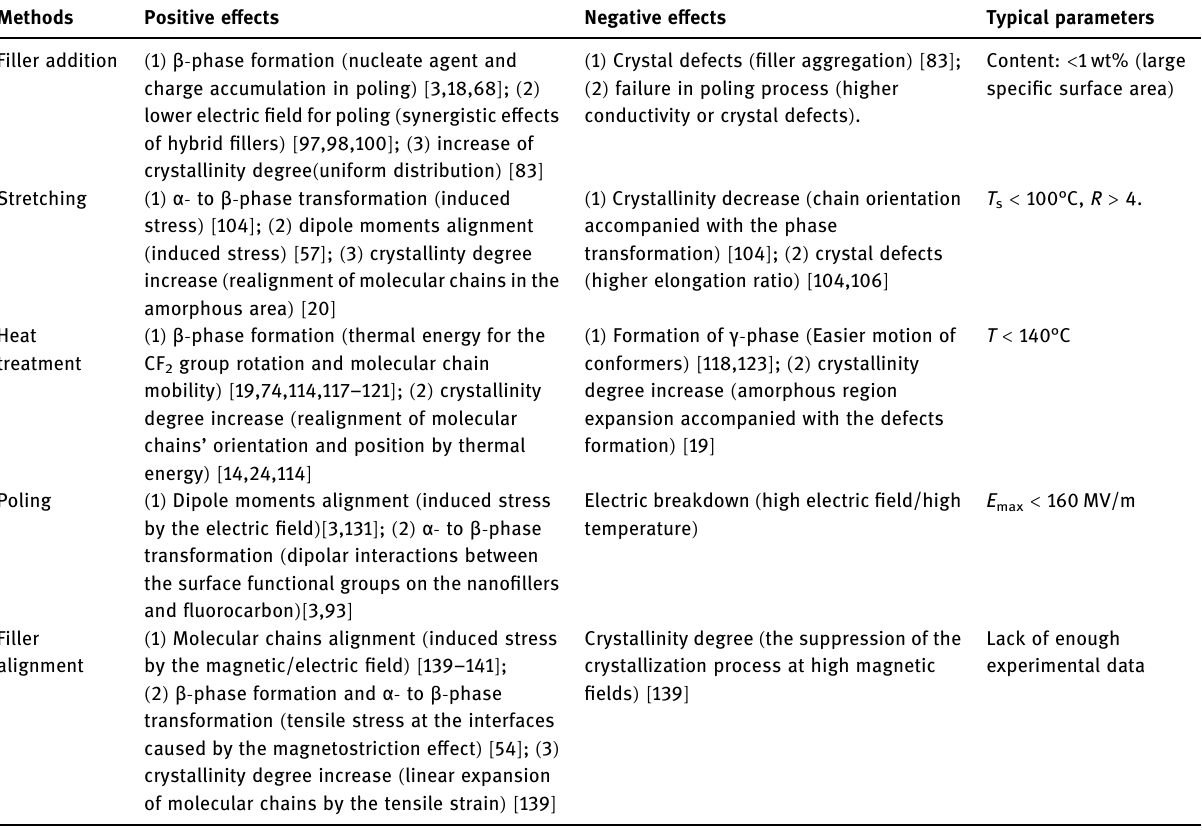
Table 5: E ff ects of di ff erent methods for improving the phase evolution in PVDF or its copolymer - based piezoelectric fi lms